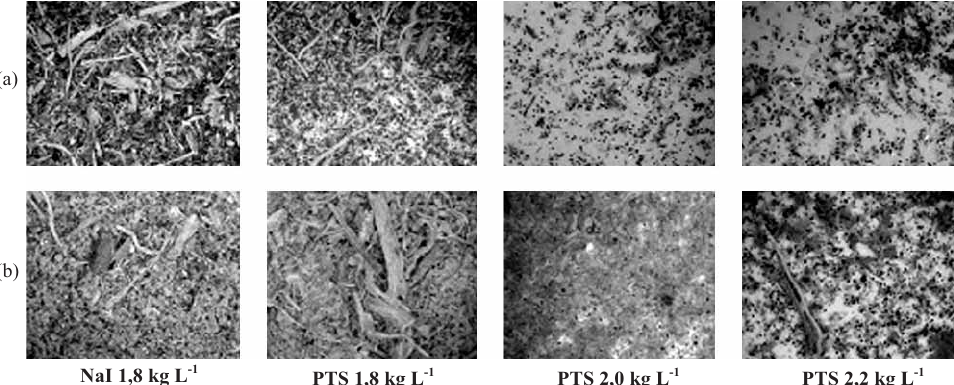
Figura 3. Detalhe da matéria orgânica particulada residual obtida por peneiramento (53 μ m) da fração pesada após separação da fração leve com soluções de iodeto de sódio (NaI) e de politungstato de sódio (PTS), em um Argissolo Vermelho (a) e Latossolo Vermelho (b).